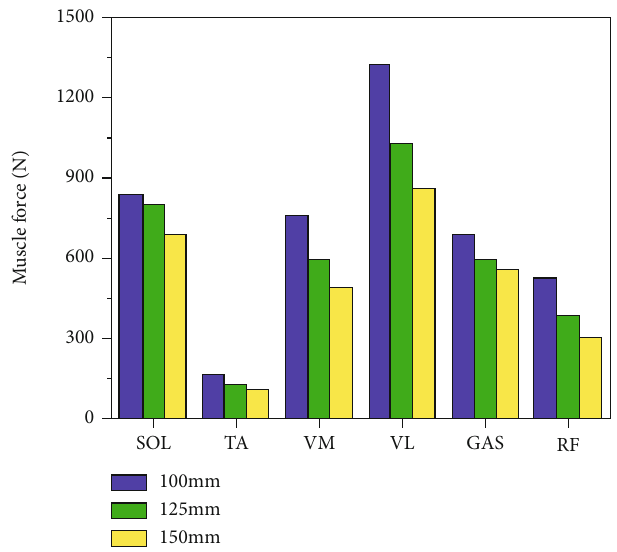
Figure 6: Maximum muscle force of each muscle in di ff erent crank